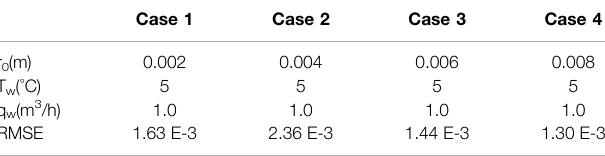
— TABLE 5 | RMSE value at different pipe inner diameter, for Example